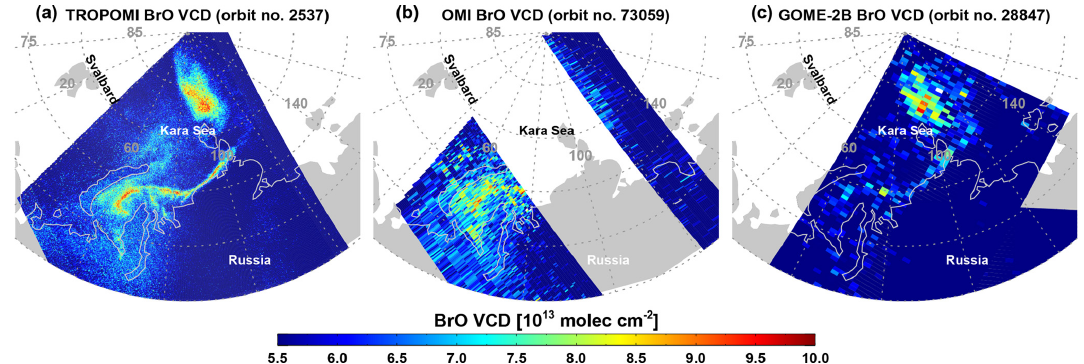
Figure 13. BrO geometric vertical columns observed over the Arctic sea ice region on 10 April 2018 by (a) TROPOMI, (b) OMI, and (c) GOME-2B.